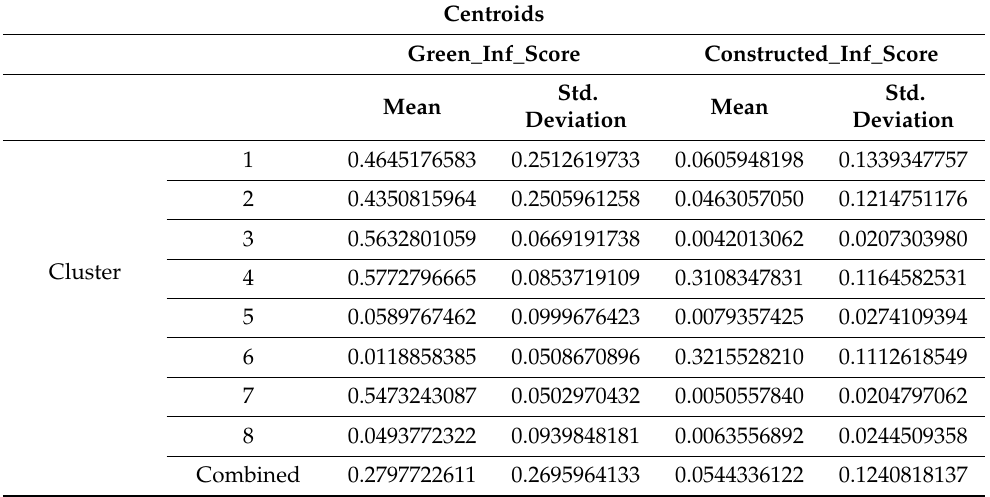
Table A4. Cluster